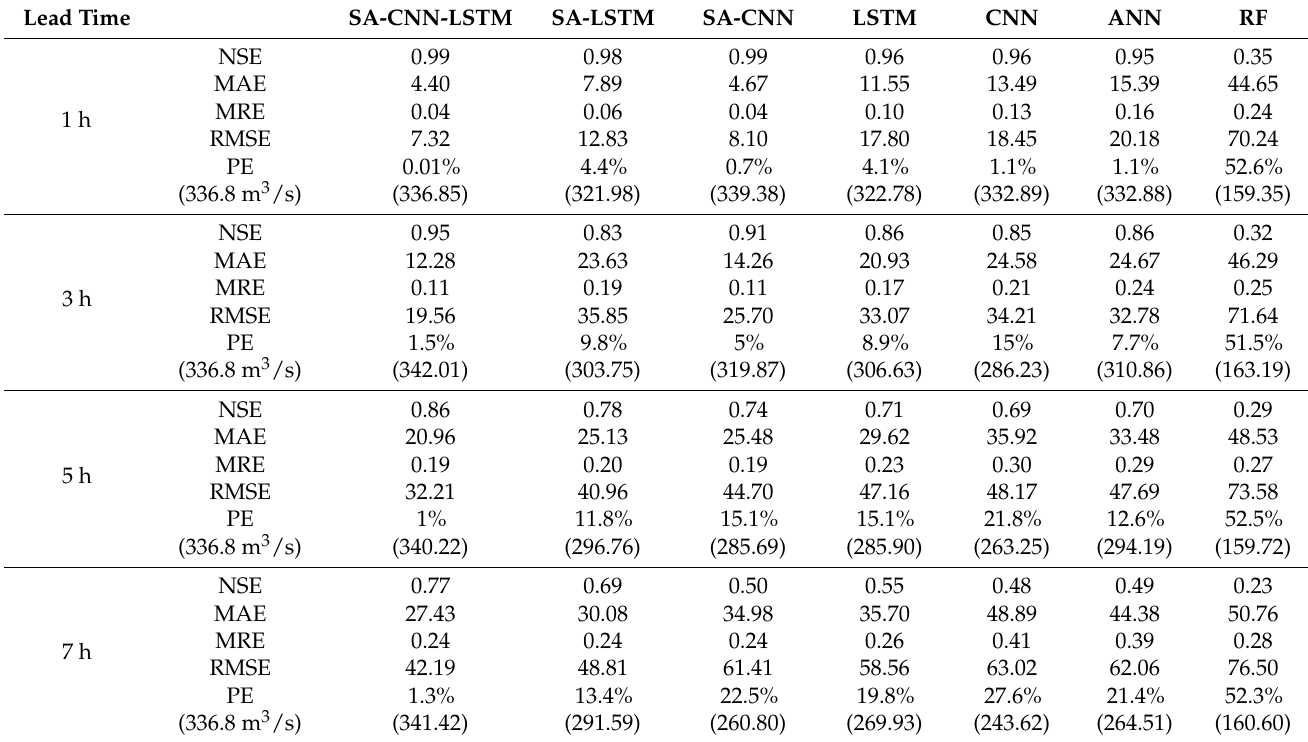
Table 5. Comparisons of evaluation indicators of flood event (2021053000) from each model at the lead times of 1, 3, 5, and 7